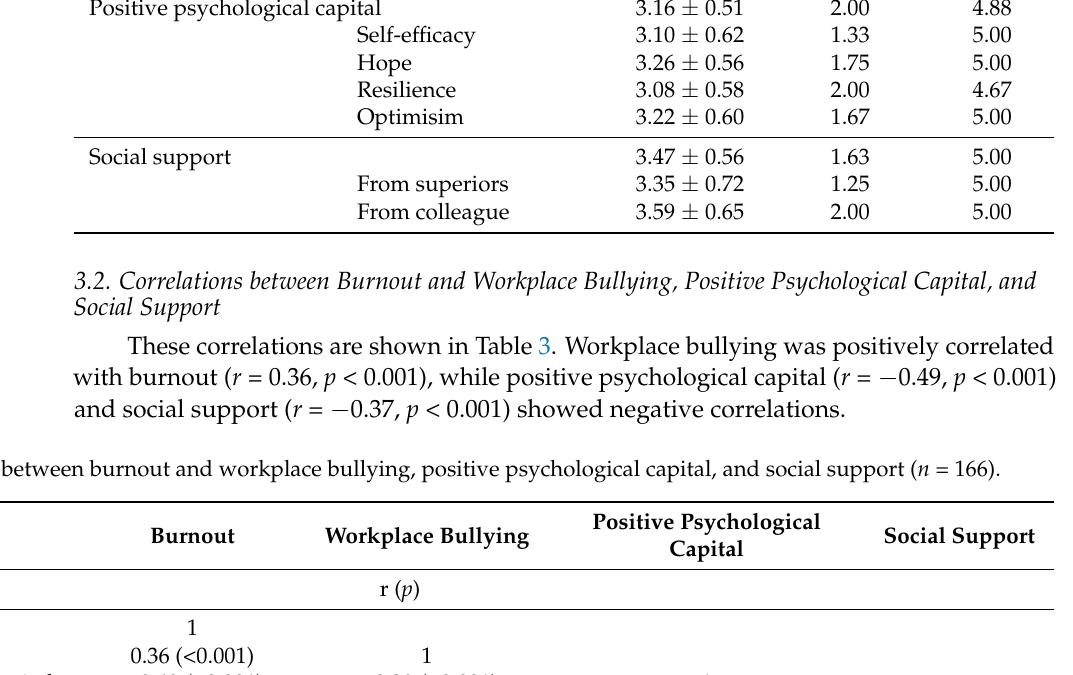
Positive Psychological Burnout Workplace Bullying Social Support Capital r ( p )